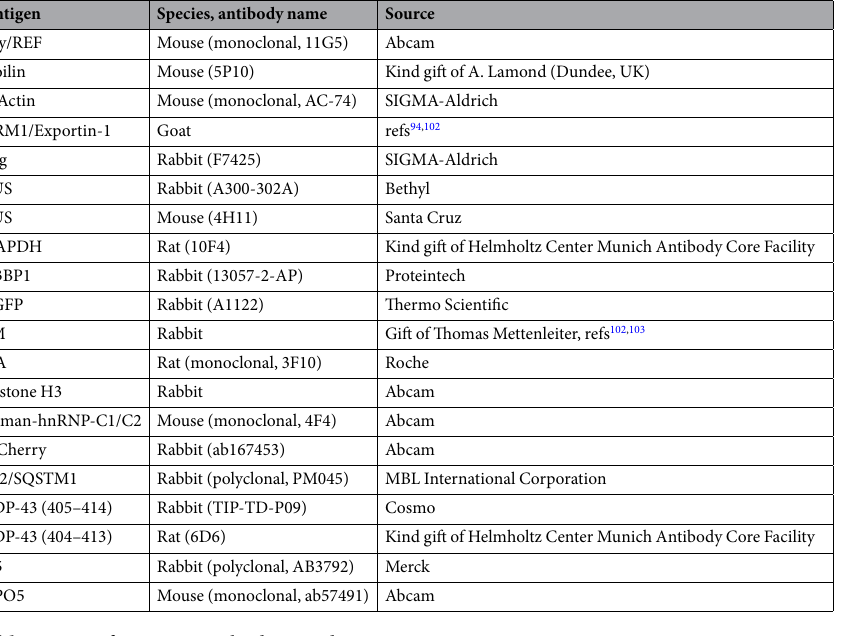
Table 1. List of primary antibodies